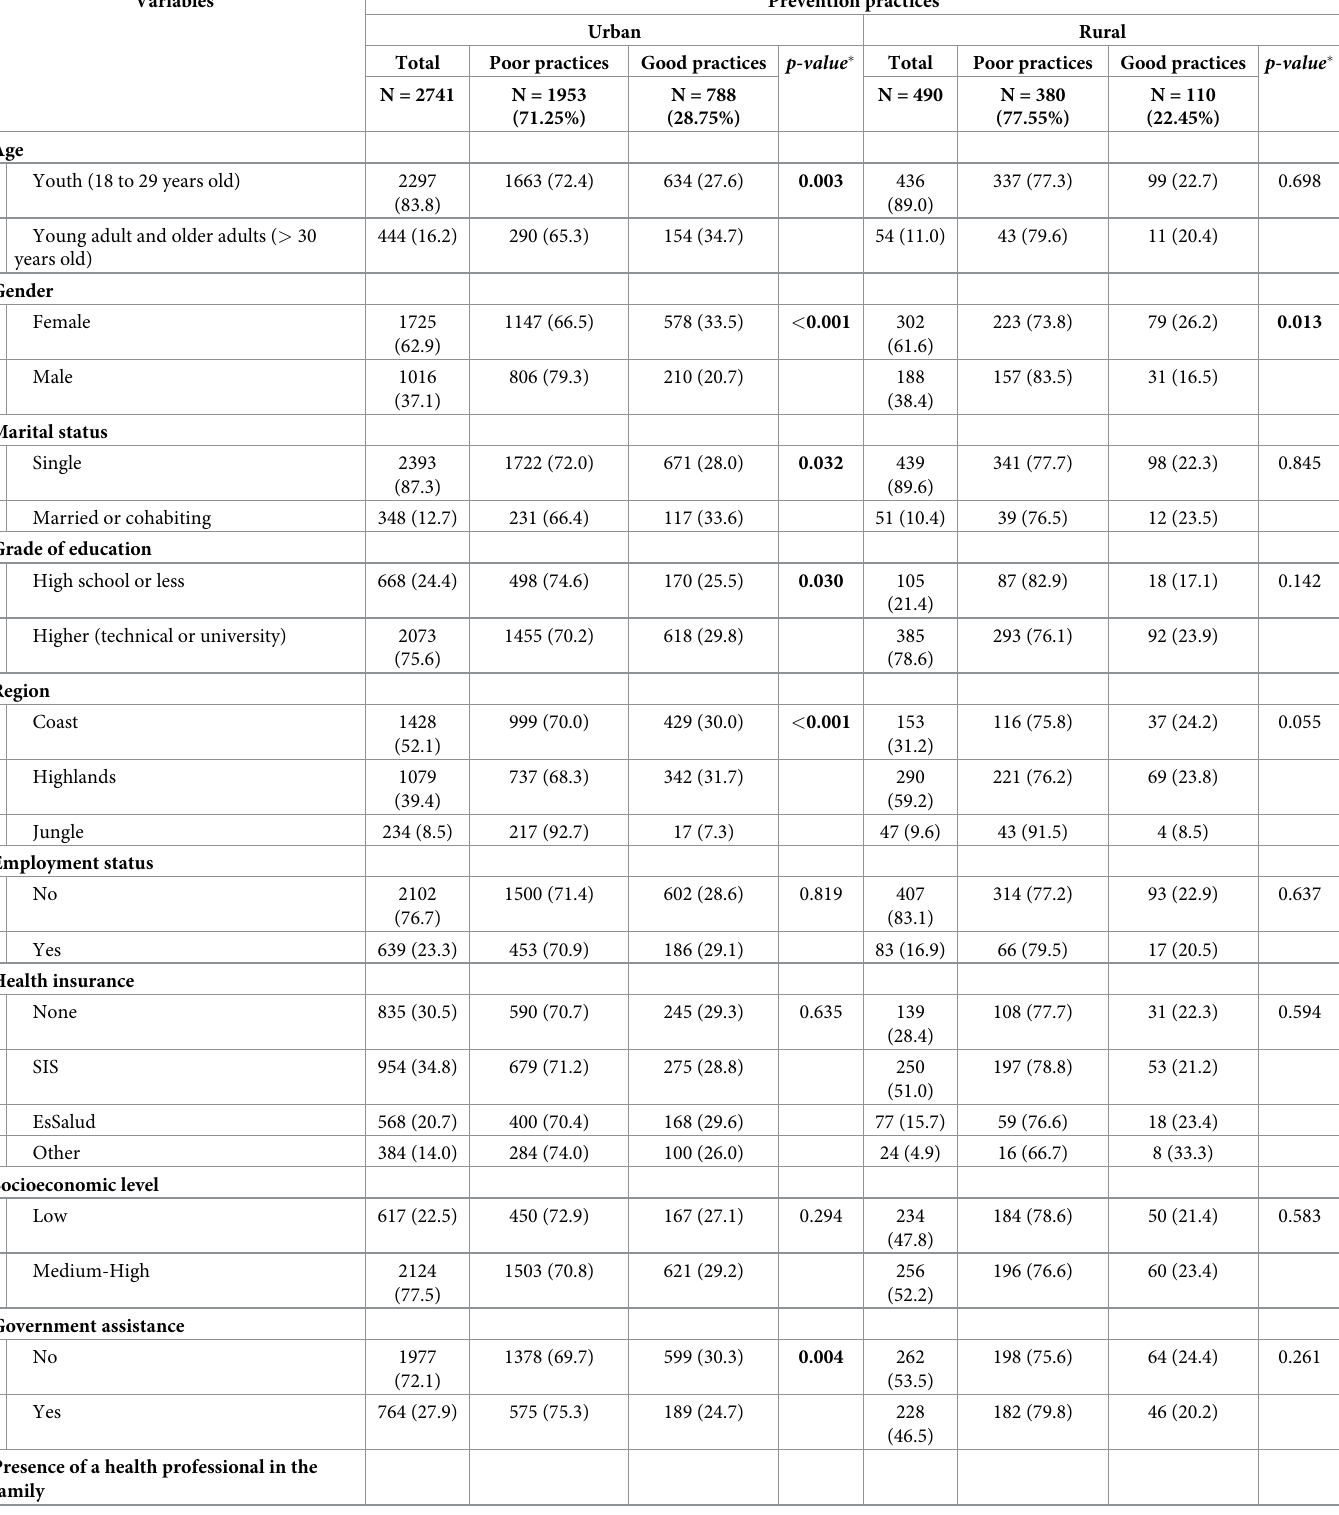
Table 1. Sociodemographic characteristics of study participants, according to rurality strata and prevention practices (N =